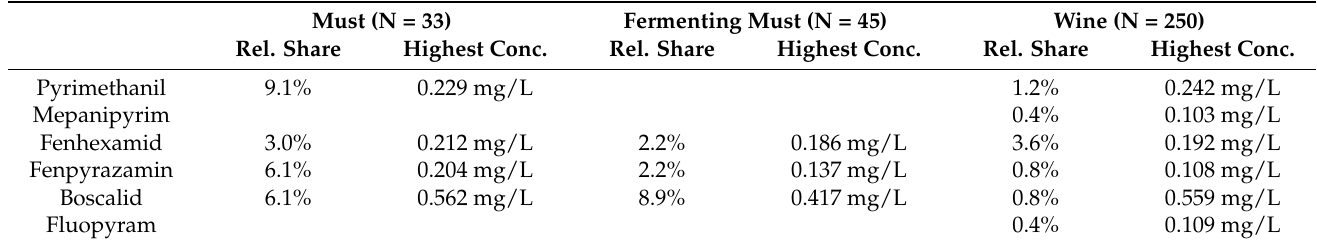
Table 4. Percentage of samples with concentrations above 100 µ